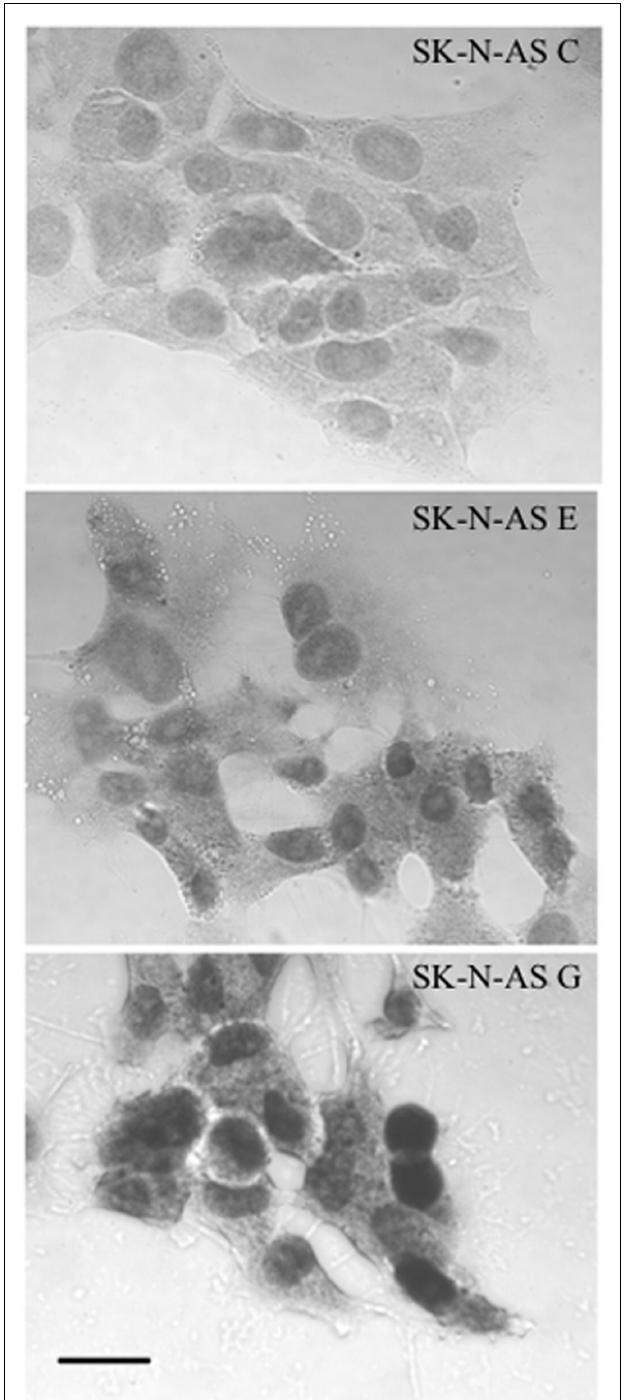
FIGUREA1 | Immunocytochemical demonstration of increased NURR1 abundance in SK-N-AS-derived clonal cell lines E and G. Note that both endogenous NURR1 (in C cells; top) and transgene-derived NURR1 (in E and G! cells: middle and bottom panels, respectively) is primarily nuclear in